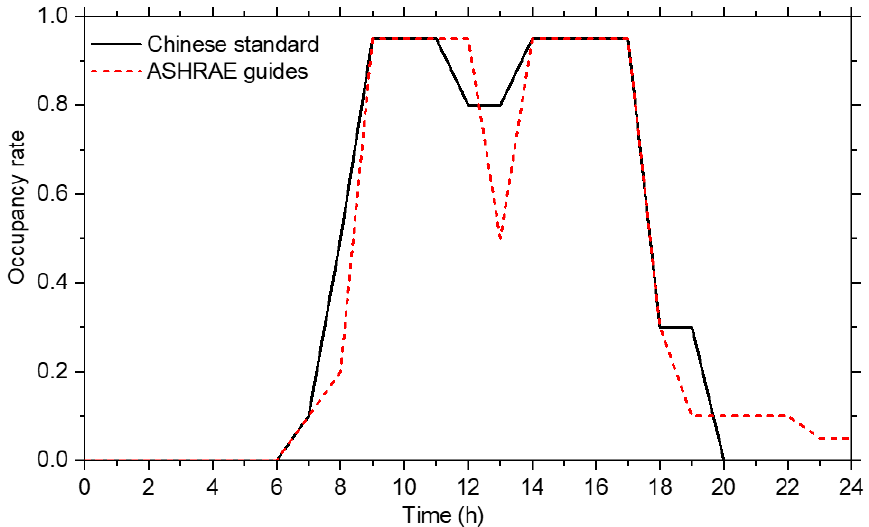
Figure 6. Occupancy rate of Chinese standard and American Society of Heating, Refrigerating and